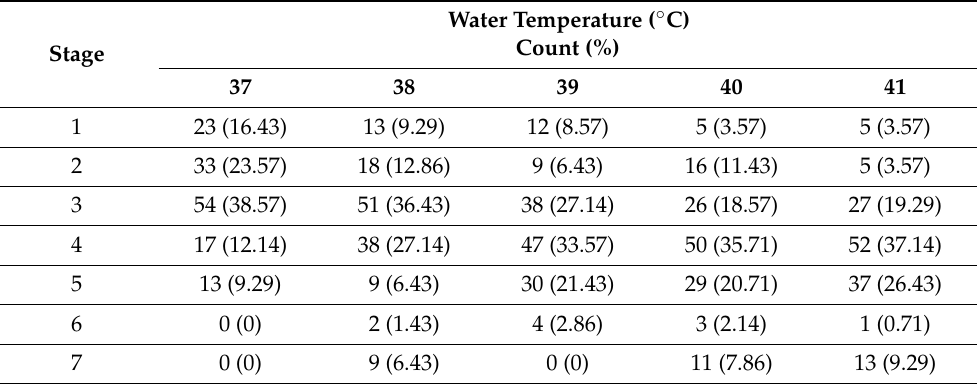
Table 4. Relationship between water temperature and the equivalent EST Bruce stage.